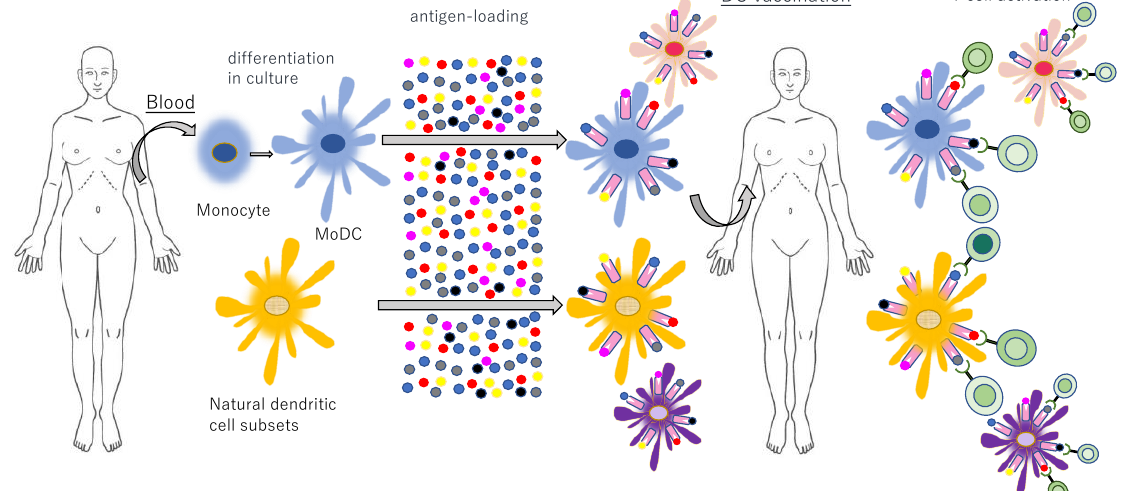
Figure 12. Adoptive transfer of autologous, antigen-loaded and activated DCs. Natural DC subsets and blood monocytes are isolated from blood and monocytes are cultured in vitro, differentiating into monocyte-derived DCs (MoDCs). After ex vivo activation and antigen loading, autologous DCs are reinfused into the patient to induce and activate antigen-specific T cells with strong efficacy and minimal side effects.